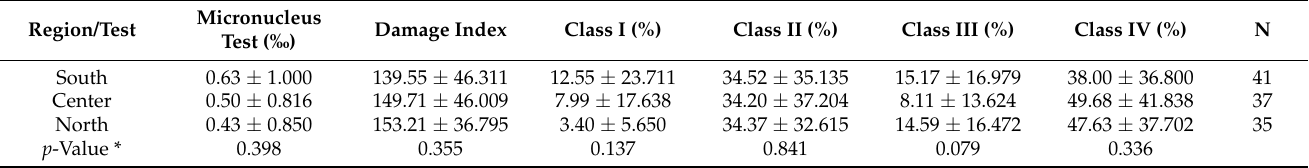
Table 5. Micronucleus test and DNA damage index assessed by comet assay from three monitored regions of the M ã e-B á Lagoon (mean ± SD).